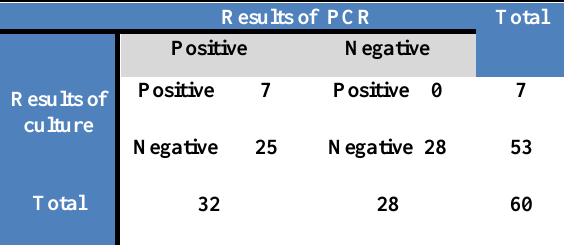
Table, 2: Compare between bacterial culture and PCR. Results of PCR Total